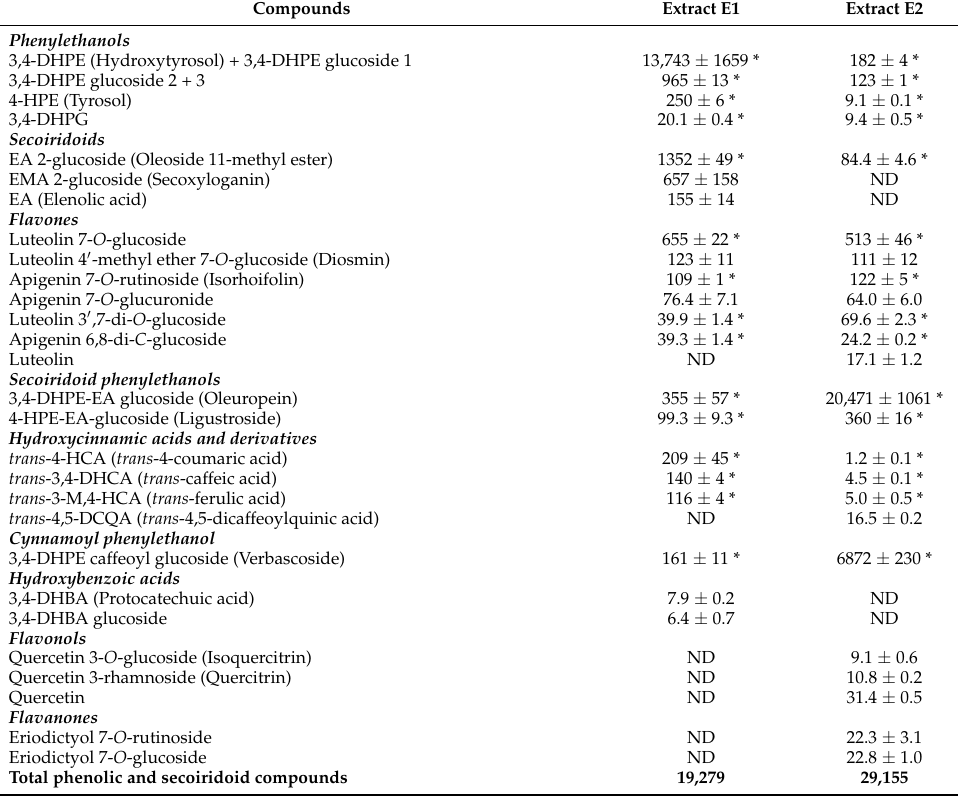
Table 2. Quantification of main phenolic and secoiridoid compounds present in olive-leaf extracts (E1 and E2). Results are expressed as mean value ± standard deviation for dry matter (mg/100 g).